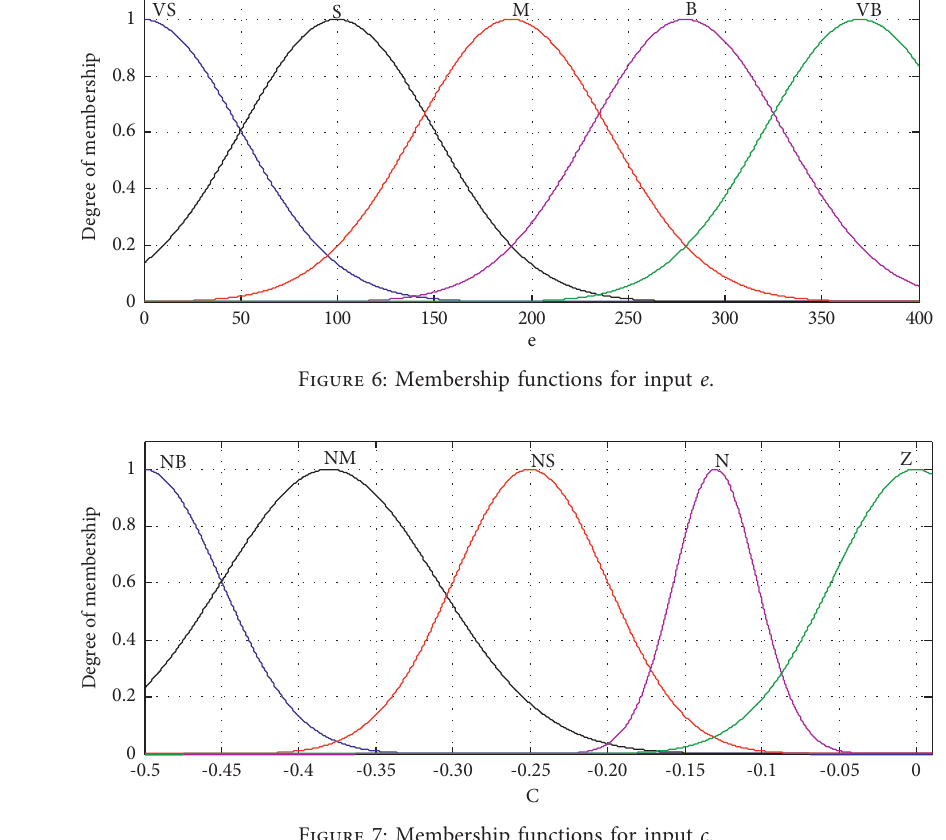
Figure 7: Membership functions for input c